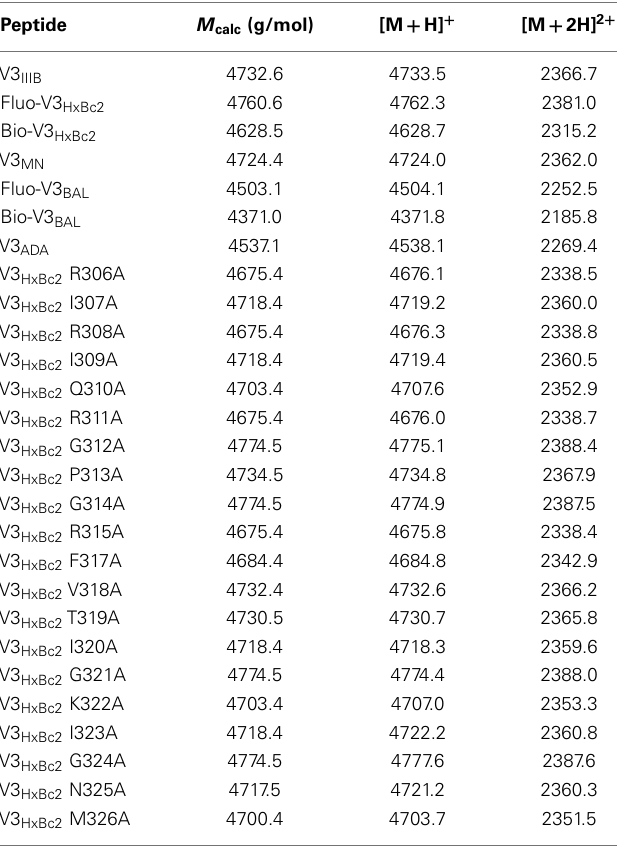
Table 1 | MALDI-TOF mass spectrometry data of synthesizedV3 loop